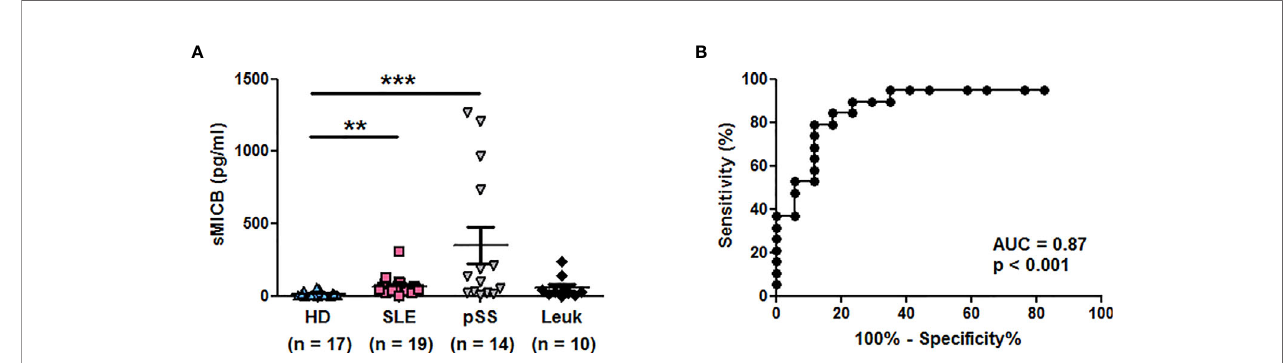
FIGURE 3 | Serum concentrations of soluble MICB in different patient groups. (A) Concentrations of sMICB have been determined by ELISA in the serum of healthy donors (HD), lupus patients (SLE), patients with primary Sjögren ’ s syndrome (pSS) and patients with leukemia (Leuk). Each dot represents an independent donor. Mean and SEM of all donors are shown. **p < 0.01; ***p < 0.001 (Kruskal-Wallis test with Dunn ’ s multiple comparison test). (B) ROC curve illustrating the power of sMICB for discrimination between SLE patients and healthy individuals. AUC, area under the curve.